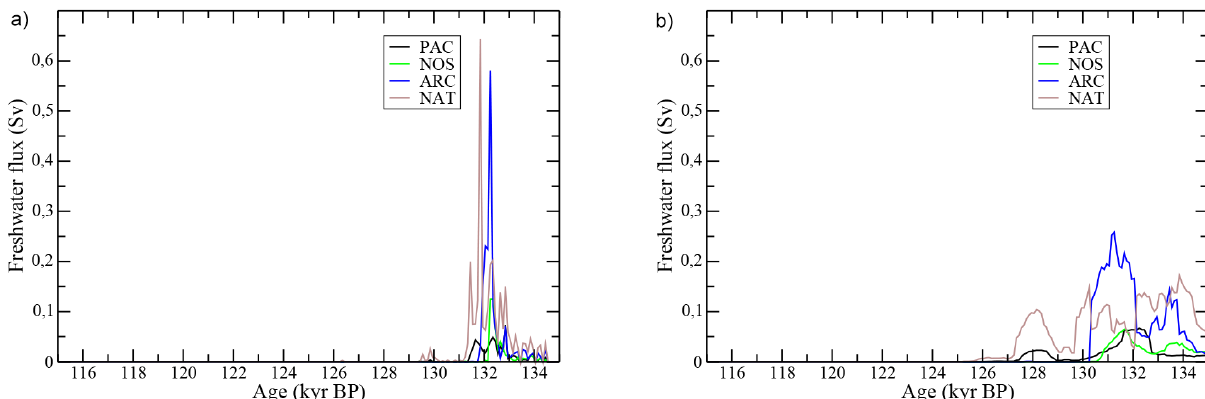
Figure 3. Freshwater flux from melting ice sheets entering the ocean for four regions: the Pacific (PAC), Arctic Ocean (ARC), North Atlantic (NAT) and North Sea (NOS). FW flux is estimated based on sea level change reconstructions from (left; a ) Grant et al. (2012) and (right; b ) Lisiecki and Raymo